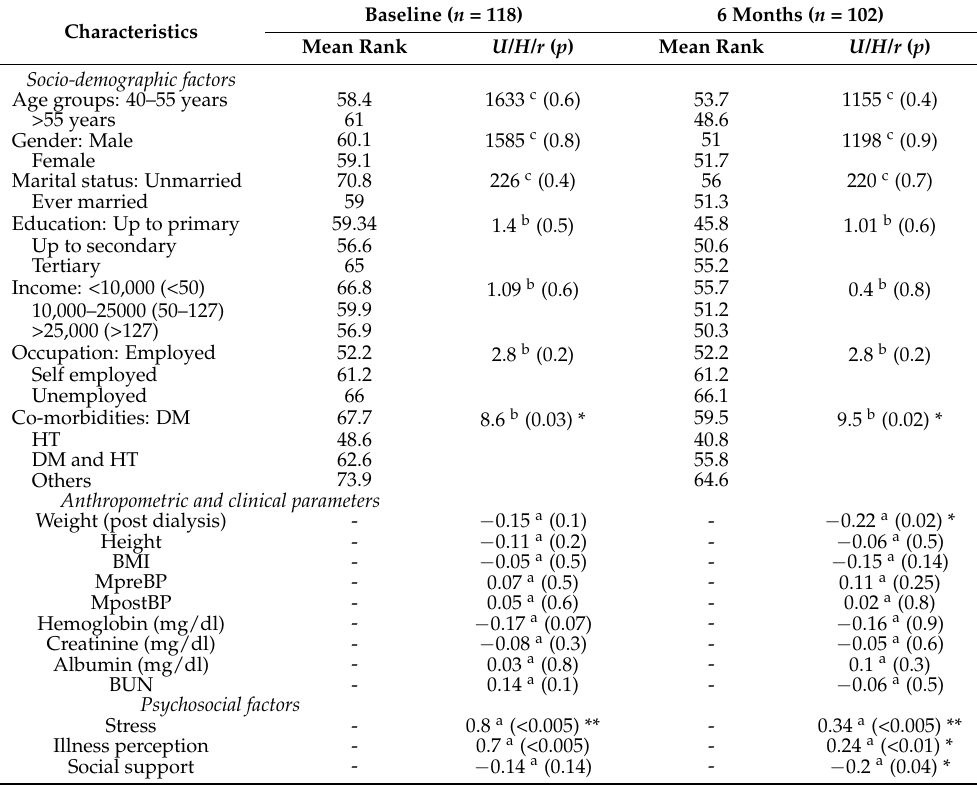
Table 4. Correlation between symptom burden and socio-demographic, clinical and psychosocial factors at baseline ( n = 118) and at 6 months ( n = 102).